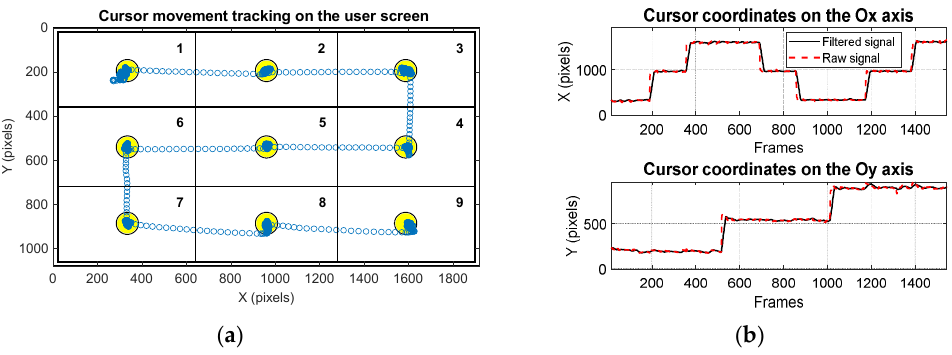
Figure 12. Real-time testing scenario: ( a ) cursor movement tracking on the user screen and ( b ) signals provided by the PDA on both axes of the coordinate system.